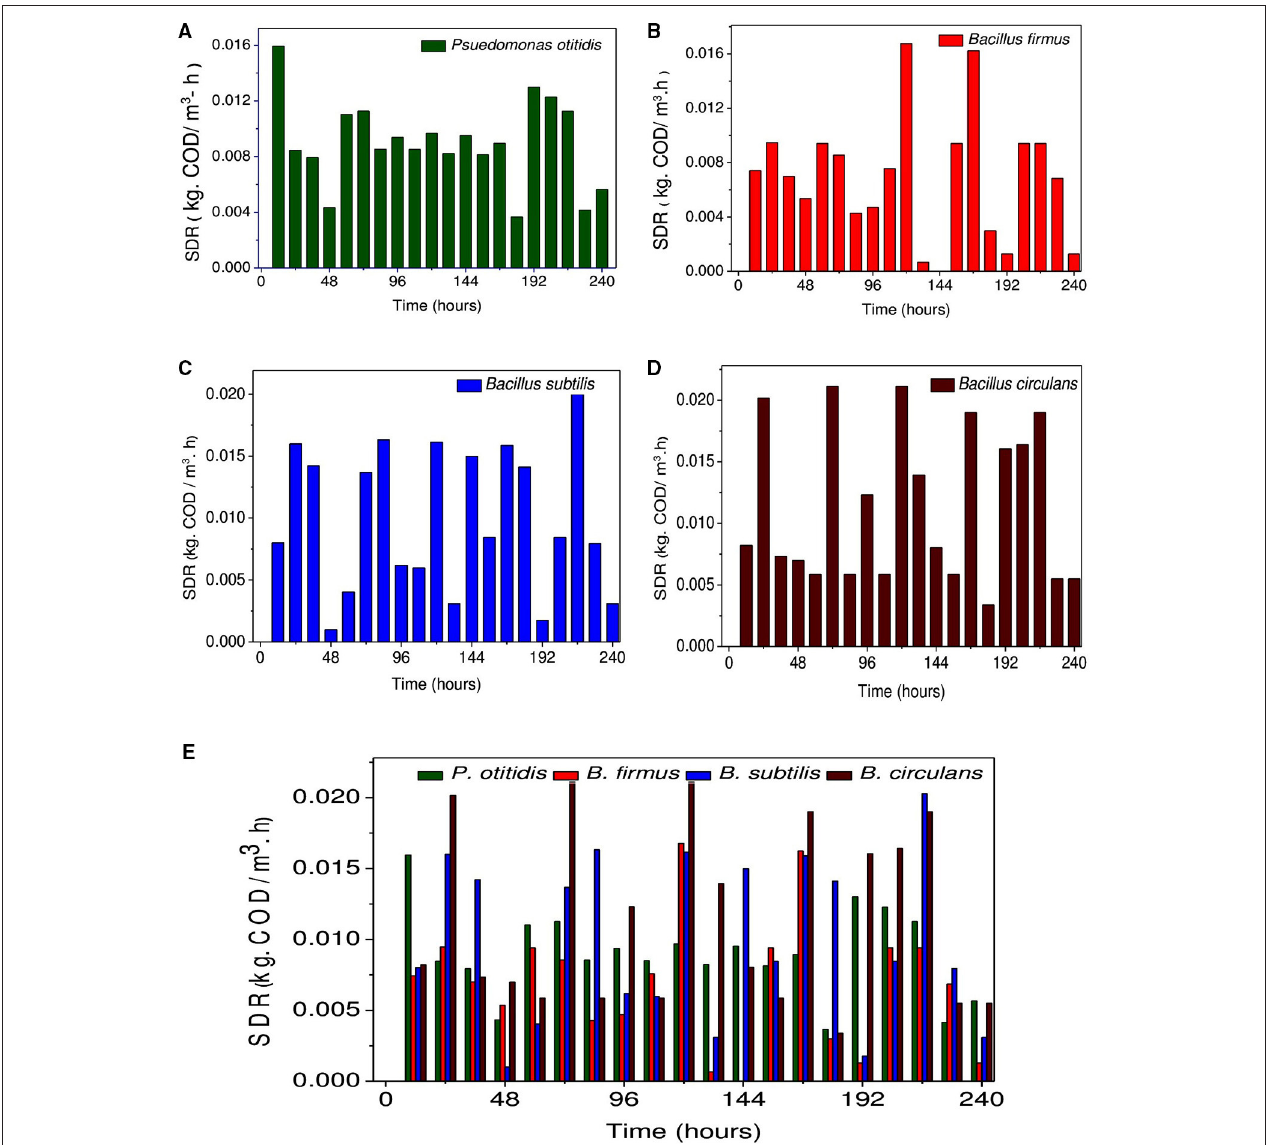
FIGURE 4 | Variation in substrate degradation rate (non-cumulative) (kg · COD T /m 3 -h) for (A) Pseudomonas otitidis , (B) Bacillus firmus, (C) Bacillus subtilis, (D) Bacillus circulans, and (E) Comparative evaluation of each isolated